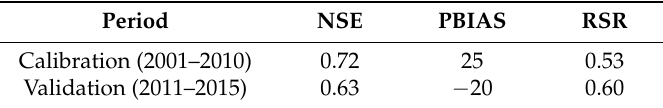
Table 2. Performance indicators PBIAS (percent bias), RSR (ratio of the root mean square error to the standard deviation), and NSE (Nash-Sutcliffe efficiency) for the calibration and validation